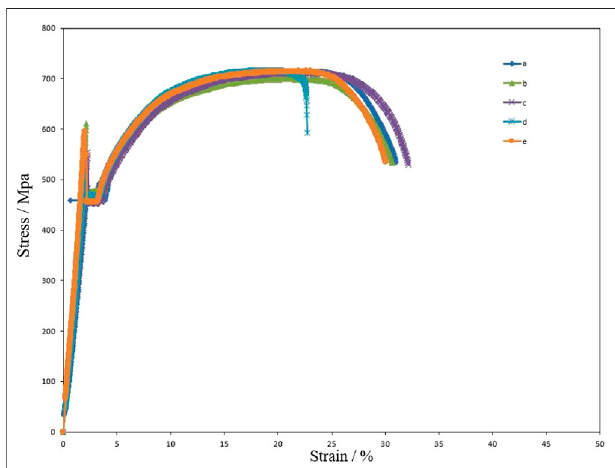
FIGURE13| Stress – straincurvesforQ235steel. (A) Original specimen; (B) specimenwithouttreatment stretchedin0.2 molL − 1 NaOH; (C) specimen stretched in air after hydrogen charged in 0.2 mol L − 1 NaOH solution for 7 days with 1 mA cm − 2 ; (D) specimen stretched in 0.2 mol L − 1 NaOH solution with 1 mA cm − 2 hydrogen charging and stretching at same time; (E) stretched in 0.2 mol L − 1 L NaOH solution with 0.1 mA cm − 2 hydrogen charging and stretching at same time.